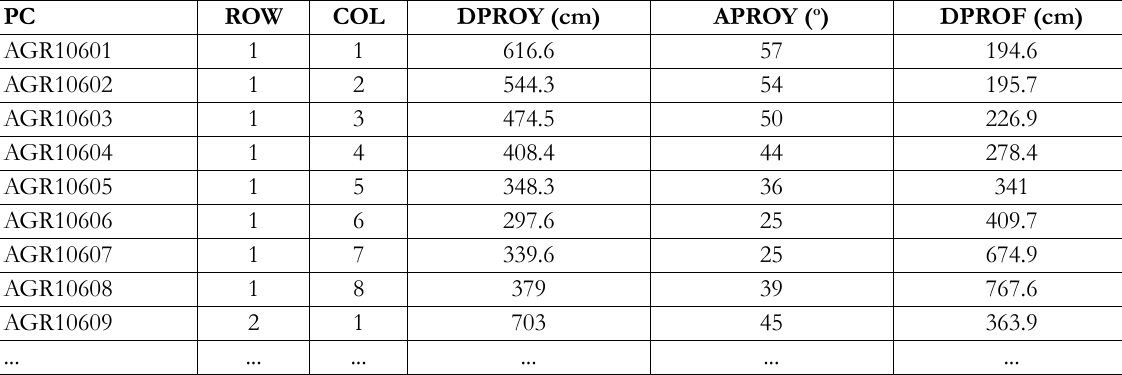
Table 2. SHEET 2. Location of each computer in the classroom with respect to the projector and the